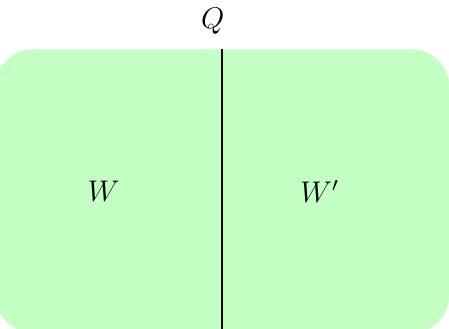
Figure 1 . An interface separating two Landau-Ginzburg models with superpotentials W and W 0 . functor that describes an interface between these models and a pair of minimal